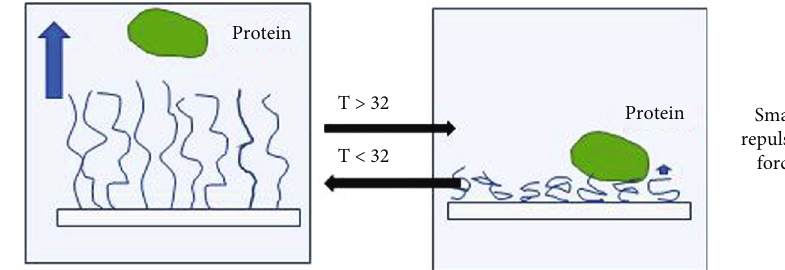
Figure 1: A schematic of PNIPAM polymer brush morphological changes due to change in solution temperature [7, 8]. Energy